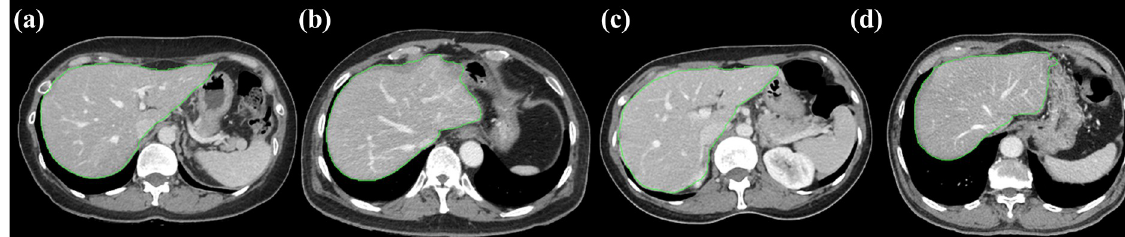
Fig 1. Sample liver segmentation results generated by the deep learning segmentation model. The results were displayed for multi-vendor CT images acquired through (a) Scanner 1, (b) Scanner 2, (c) Scanner 3, and (d) Scanner 4, respectively.